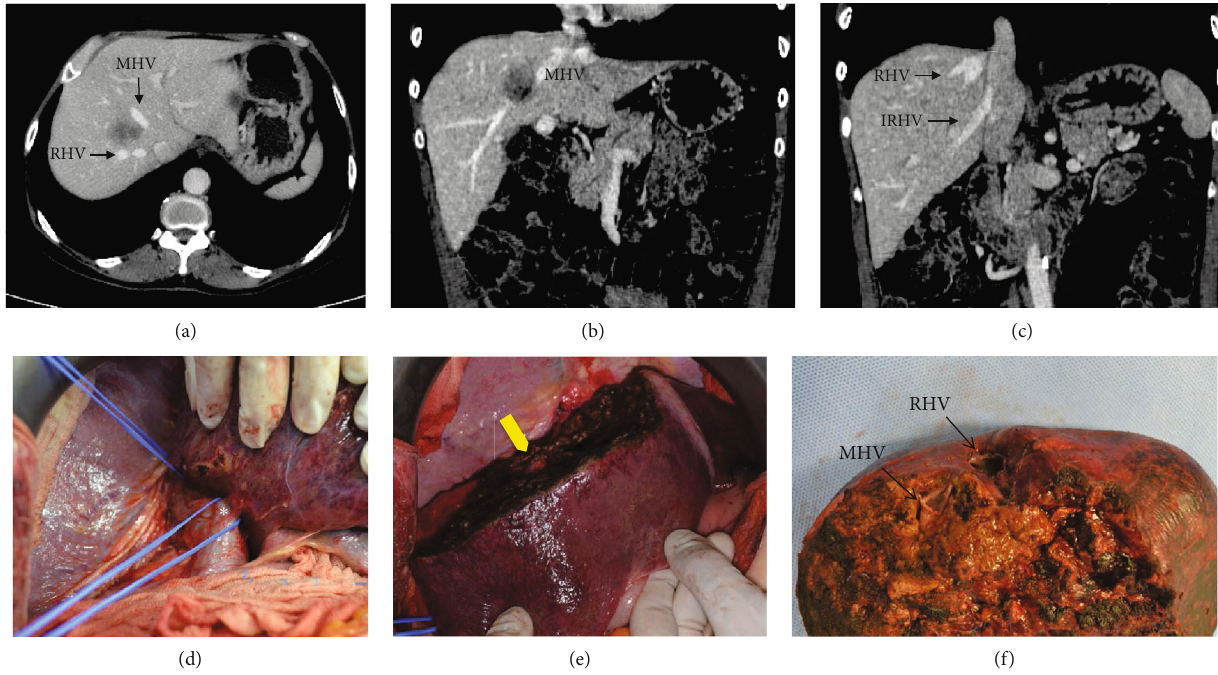
Figure 2: (Patient 1) (a) Colorectal metastasis with no margin from RHV and MHV. (b) Local invasion of MHV. (c) Inferior right hepatic vein draining the right inferior segments (S5 and S6). (d) Liver mobilization and preservation of IRHV (asterisk). (e) Middle hepatic vein ligated (yellow arrow). (f) Surgical specimen (liver segments 4A, 8, and